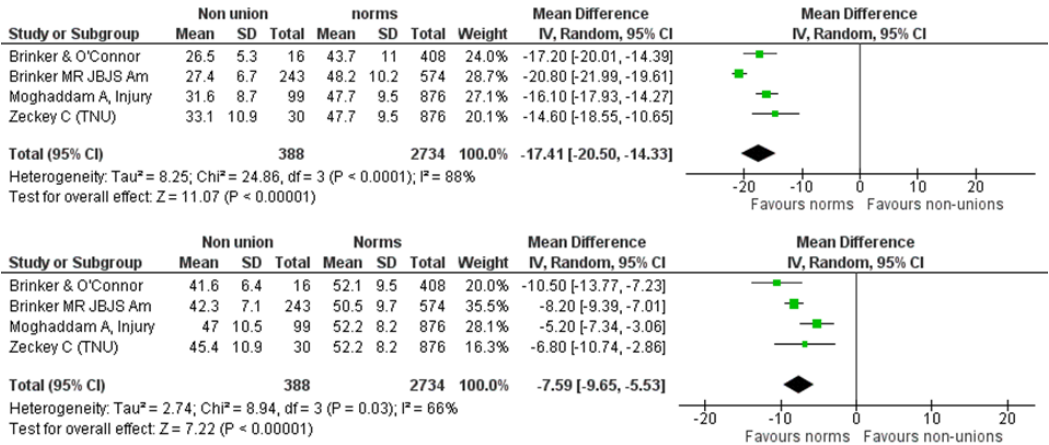
Figure 7. SF-12 PCS and MCS pooled analysis between tibial non-unions and norm.